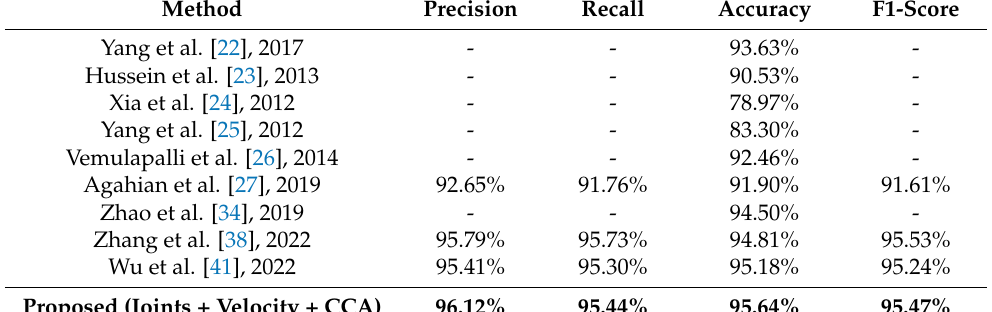
Table 5. Performance comparisons of HAR methods on the MSR-Action3D dataset.